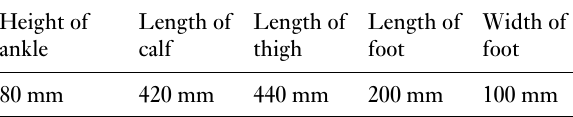
Figure 9 Outer exoskeleton model. Table 1 Parameters of the human model's lower limbs